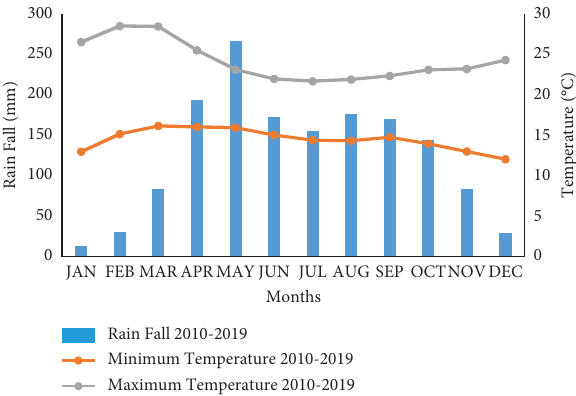
Figure 3: Ten years (2010–2019) monthly average rainfall and temperature data of Kechi farm [18]. Table 1: SQI evaluation based on assigned range values of soil